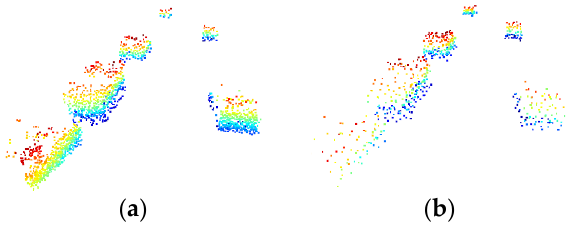
Figure 10. Comparison of P-FPS and FPS on recalling GT points: ( a ) P-FPS (recall 1507 points); ( b ) FPS (recall 575 points).